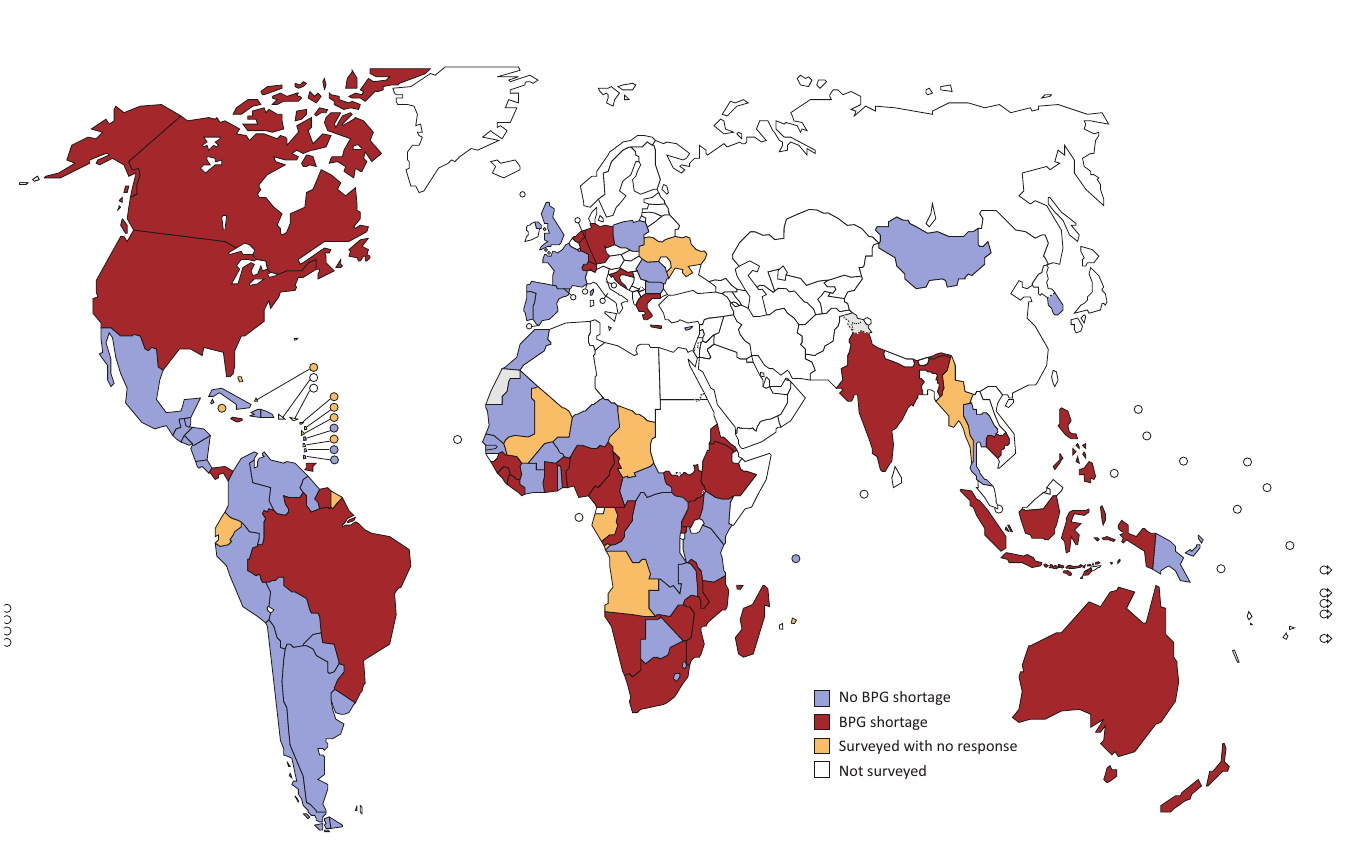
Fig 1. Countries with reported shortages of benzathine penicillin G (BPG) during